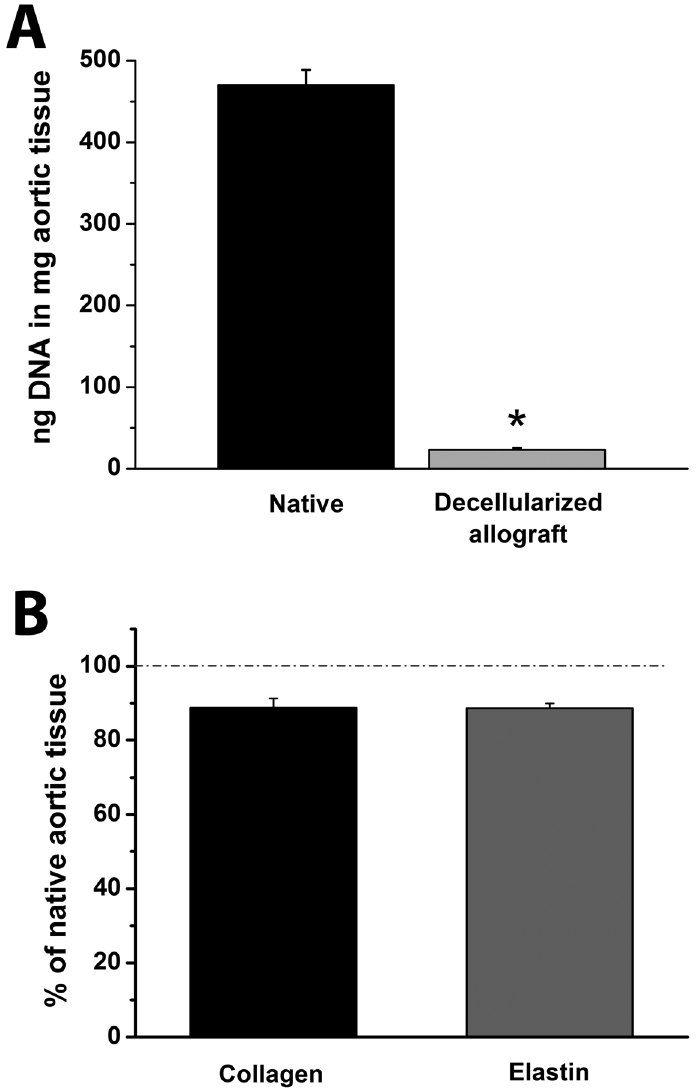
Figure 3. DNA, collagen and elastin content. Total DNA content of native aortic arch tissue and decellularized aortic arch allografts (A). Collagen and elastin content of decellularized aortic arch allograft samples compared to that of native aortic arch tissue (B) *:P , 0.05 vs. Native aortic arch